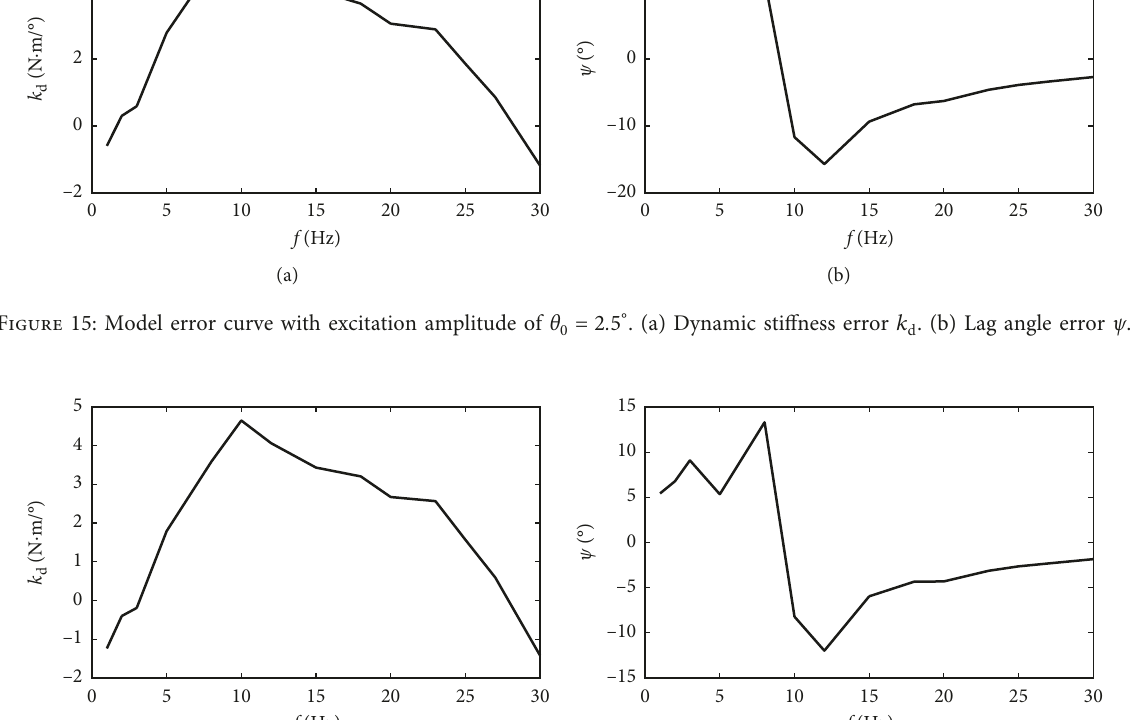
. 5 ° . (a) Dynamic stiffness error k 0 (cid:31) 3